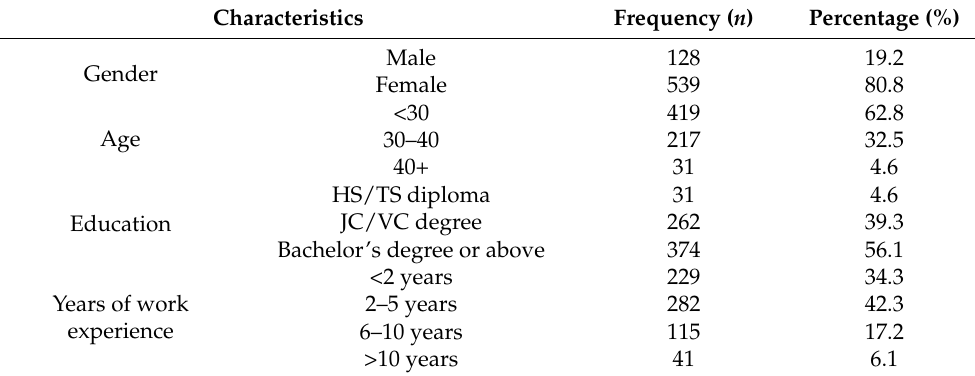
Table 1. Participant demographics ( n =